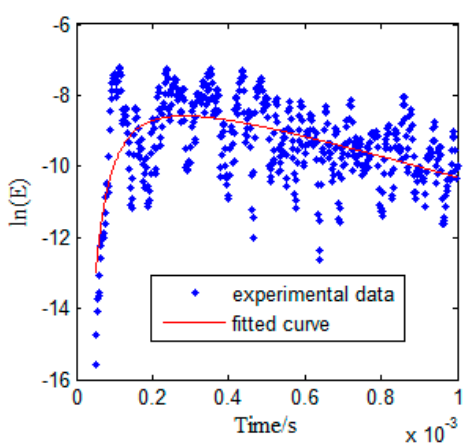
Figure 9. Ultrasonic energy density curves of Lamb waves with different damages under an excitation pulse with a center frequency of f = 2.1 MHz, when there is no damage.